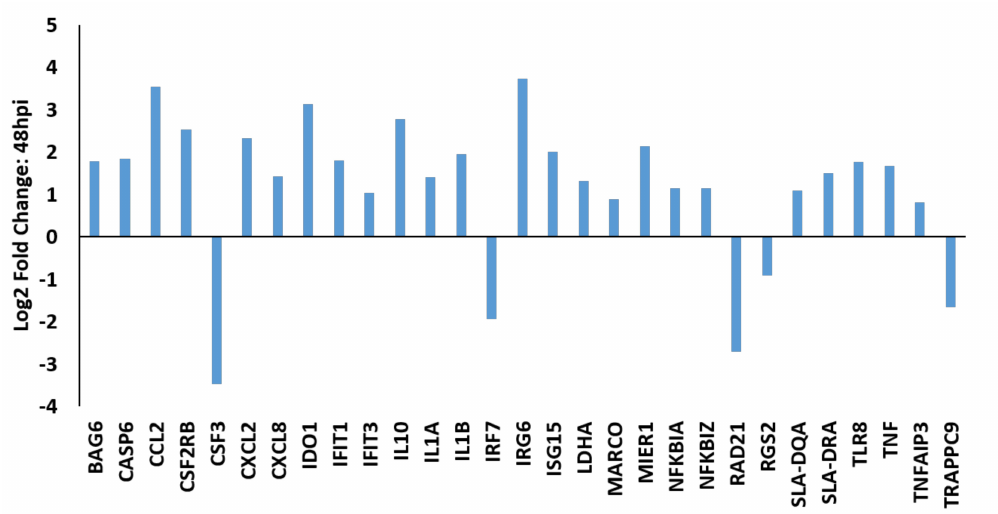
Figure 3. A selection of di ff erentially expressed genes in PRRSV-infected macrophages at 48 hpi. PAMs ( n = 3) were either infected with PRRSV strain VR-2332 or mock infected and total RNA was collected at 48 h and subjected to RNA-sequencing. All values are provided as the log 2 fold di ff erences of gene expression levels in PRRSV-infected PAMs relative to mock-infected PAMs. All genes shown were statistically significantly di ff erent (FDR-corrected p < 0.05) between the groups.